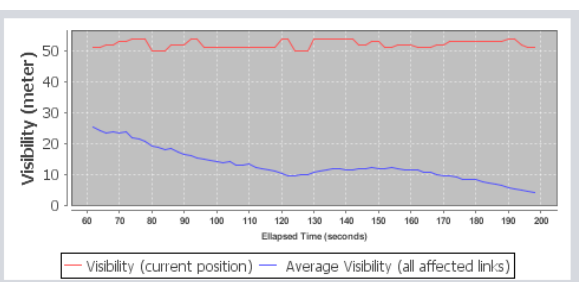
Figure 13. Carbon monoxide density-time chart.